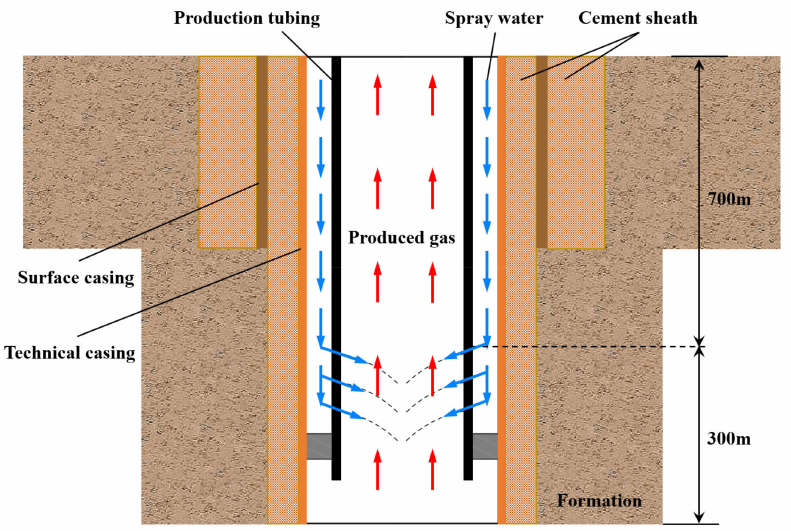
Figure 3. Annulus water injection spray cooling process.